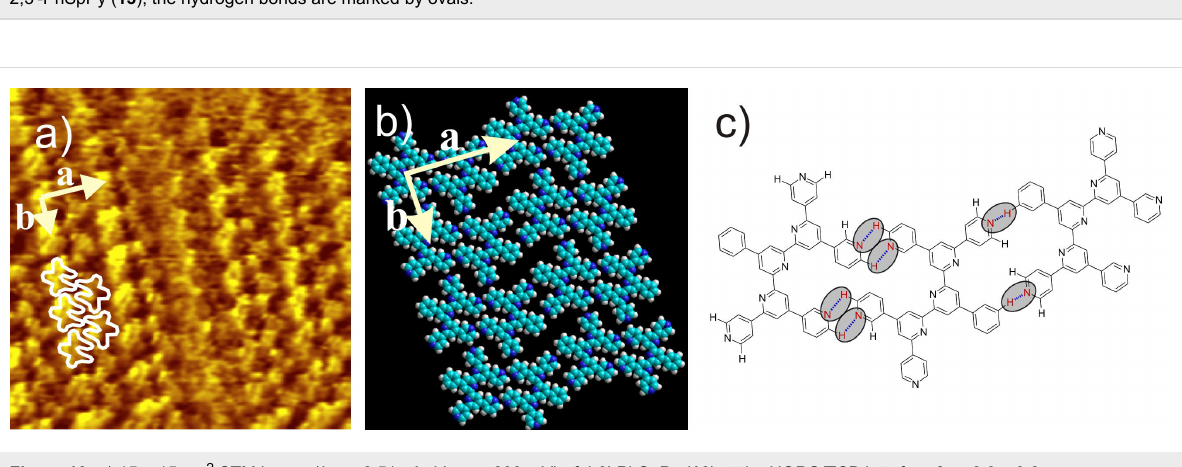
Figure 10: a) 15 × 15 nm 2 STM image ( I set = 2.51 nA, V set = − 600 mV) of 4,3'-PhSpPy ( 16 ) at the HOPG/TCB interface [ a = 2.8 ± 0.2 nm, b = 1.7 ± 0.2 nm, a,b = 93 ± 3°] with five overlaid molecules; b) model of the 4,3'-PhSpPy ( 16 ) lamellar pattern; c) hydrogen bonding motif of 4,3'-PhSpPy ( 16 ); the hydrogen bonds are marked by